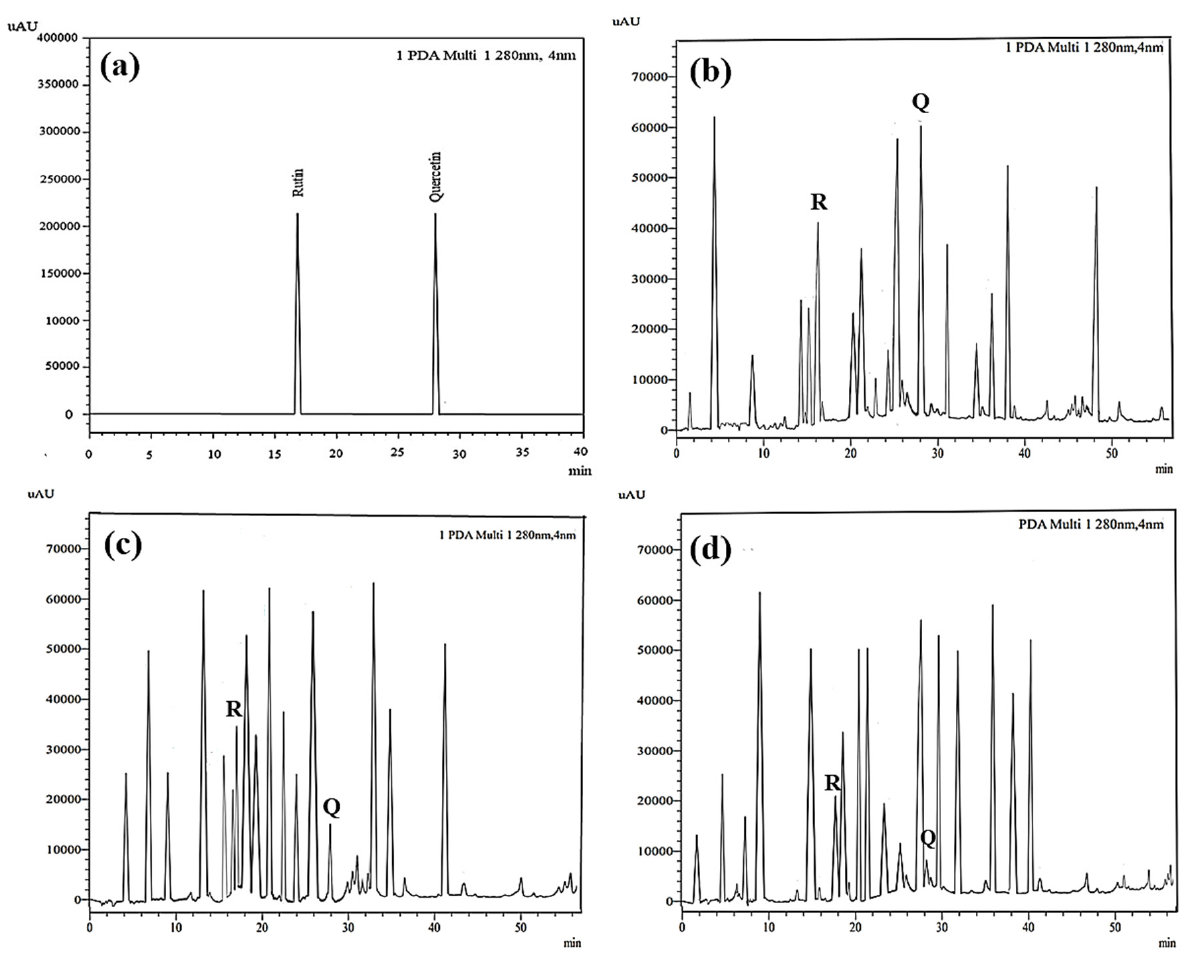
Figure 5. HPLC profiles acquired at 280 nm of ( a ) standard rutin and quercetin and ethanolic extracts obtained from ( b ) U. dioica leaves, ( c ) M. chamomilla flowers, and ( d ) M. koenigii leaves, showing different bioactive compounds. R stands for rutin, and Q stands for quercetin. Table 6. Major phytochemical compounds identified in ethanolic extracts of U. dioica, M. chamomilla , and M. koenigii .